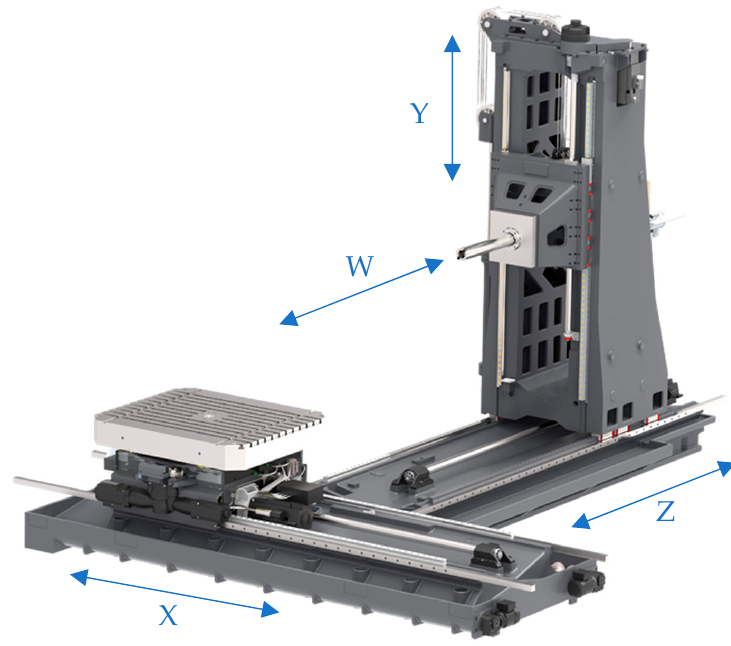
Figure 10. Machining center used for the proposed method verification. Table 1. Cutting conditions for workpiece machining.